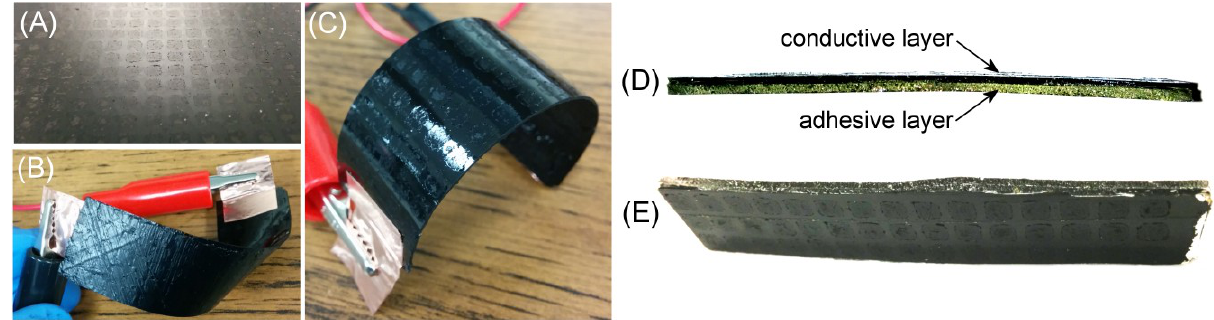
Figure 5. ( A ) A composite carbon-doped SMP sheet with 30 wt% islands and 15 wt%